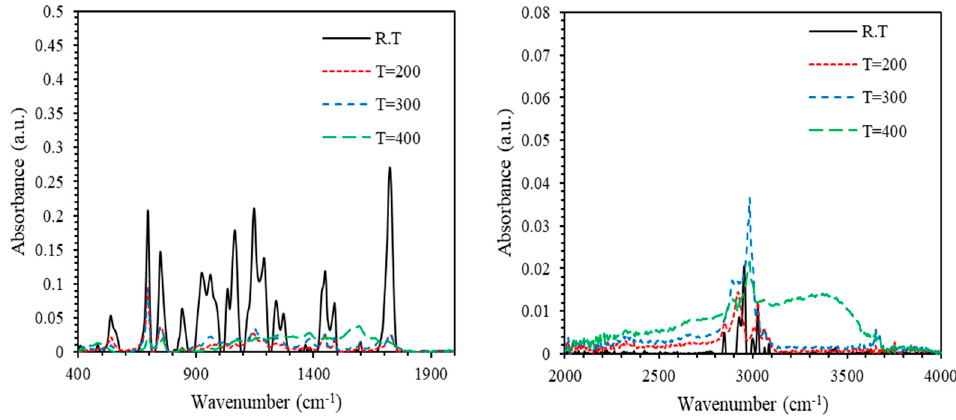
Figure 11. The absorbance of PMMA-PS/5% CeO 2 processed at different annealing temperatures.